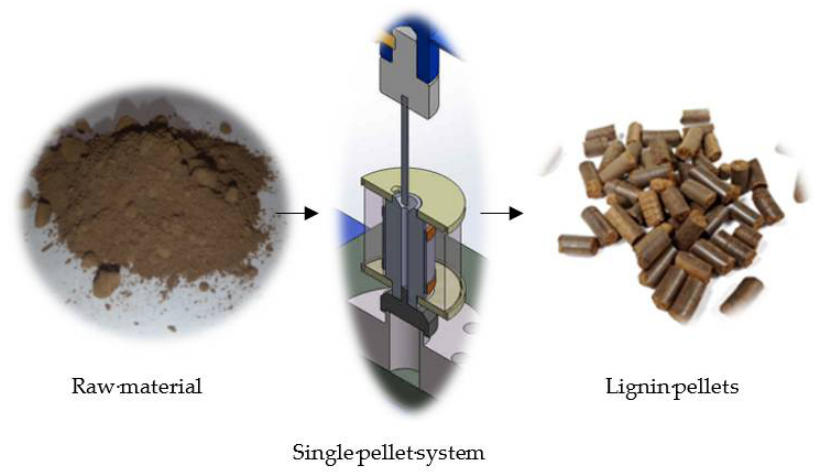
Figure 3. Pellet production process using the single pellet system employed at the Biomass Technology Laboratory.